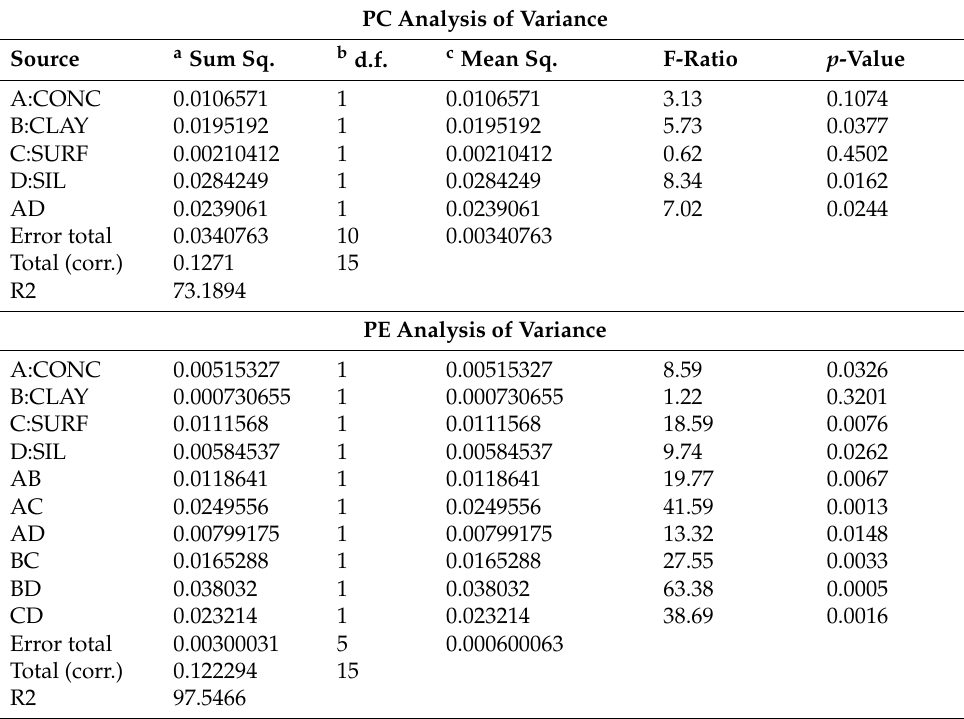
Table 7. ANOVA analysis for the interlaminar space d(001)nm response from the hybrid pigments with PC and PE under different synthesis conditions